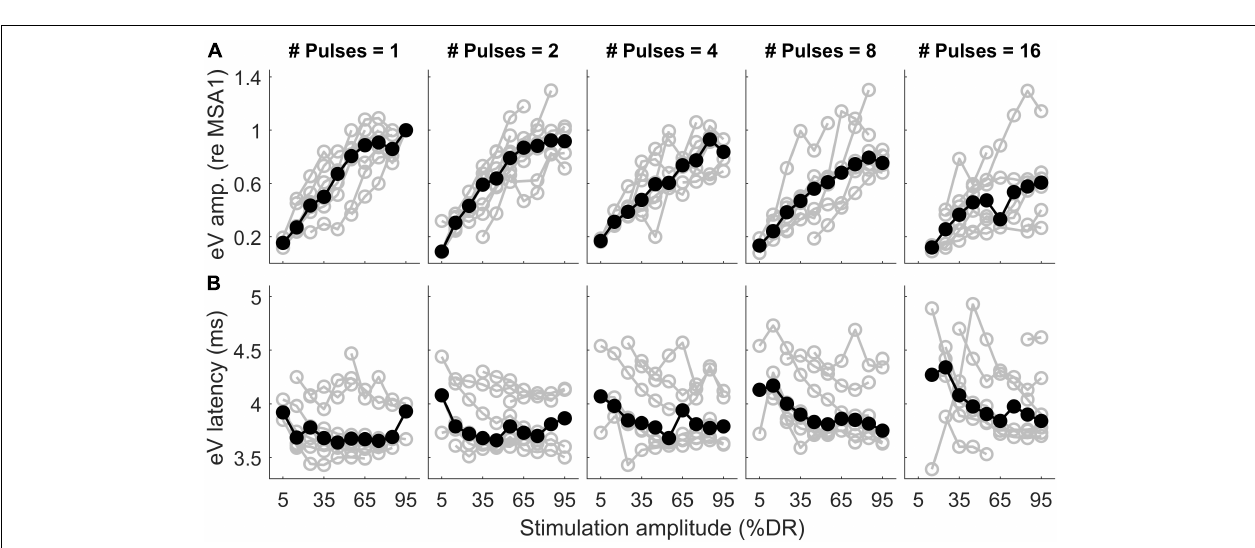
FIGURE 10 | eABR eV latencies of multi-pulse conditions over all subjects. In each panel, the stimulation amplitude is constant [MSA2, MSA4, MSA8, MSA16 in panels (A–D) , respectively]. Data from individual subjects are plotted in gray circles and their corresponding median values in colors, which match the colors in Figure 7 . Data of the MSA1 condition (blue points in Figure 7 ) are not plotted, as all were 0 due to normalization. The asterisk shows pairs with significant difference.